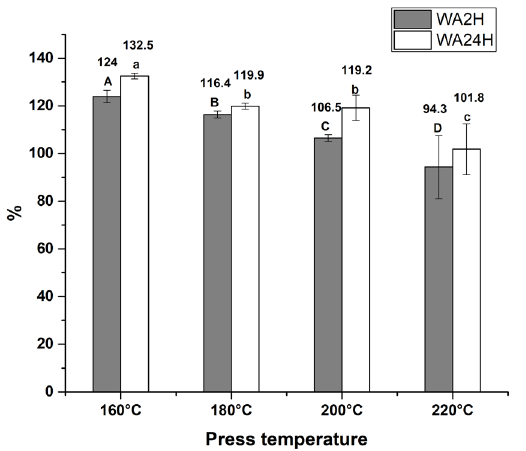
Figure 2. Water absorption for particleboard panels produced with sugarcane bagasse and plastic bag particles at different pressing temperatures. *Averages followed by a similar letter (uppercase for WA2h and lower case for WA24h did not differ statistically by the Scott-Knott test at a 5% significance level.